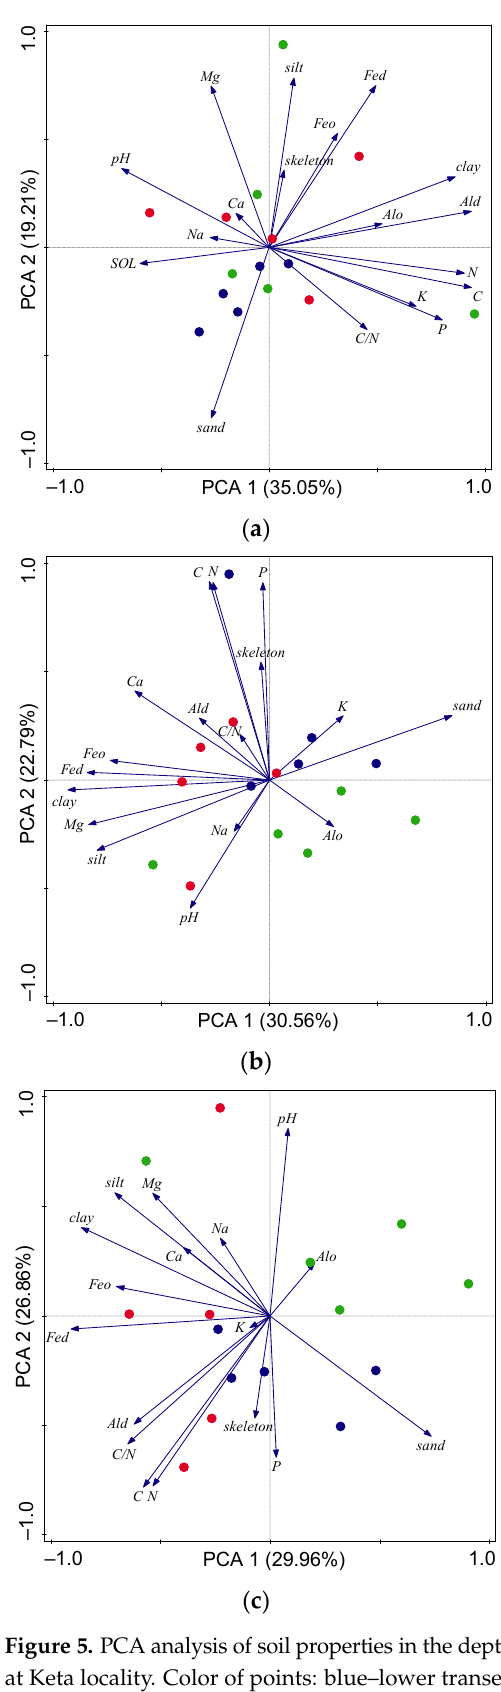
Figure 5. PCA analysis of soil properties in the depth of soil ( a ) 0–0.1 m, ( b ) 0.1–0.2 m and ( c ) 0.2–0.3 m at Keta locality. Color of points: blue–lower transect, green–middle transect, red–upper transect.